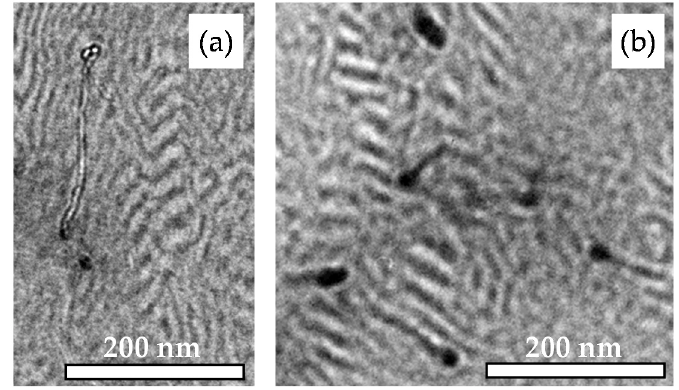
Figure 6. Magnified TEM images of sample LN3_1_D: ( a ) size comparison between the BCP domains and the MWCNTs and ( b ) visualization of the MWCNT localization in the BCP lamellas .